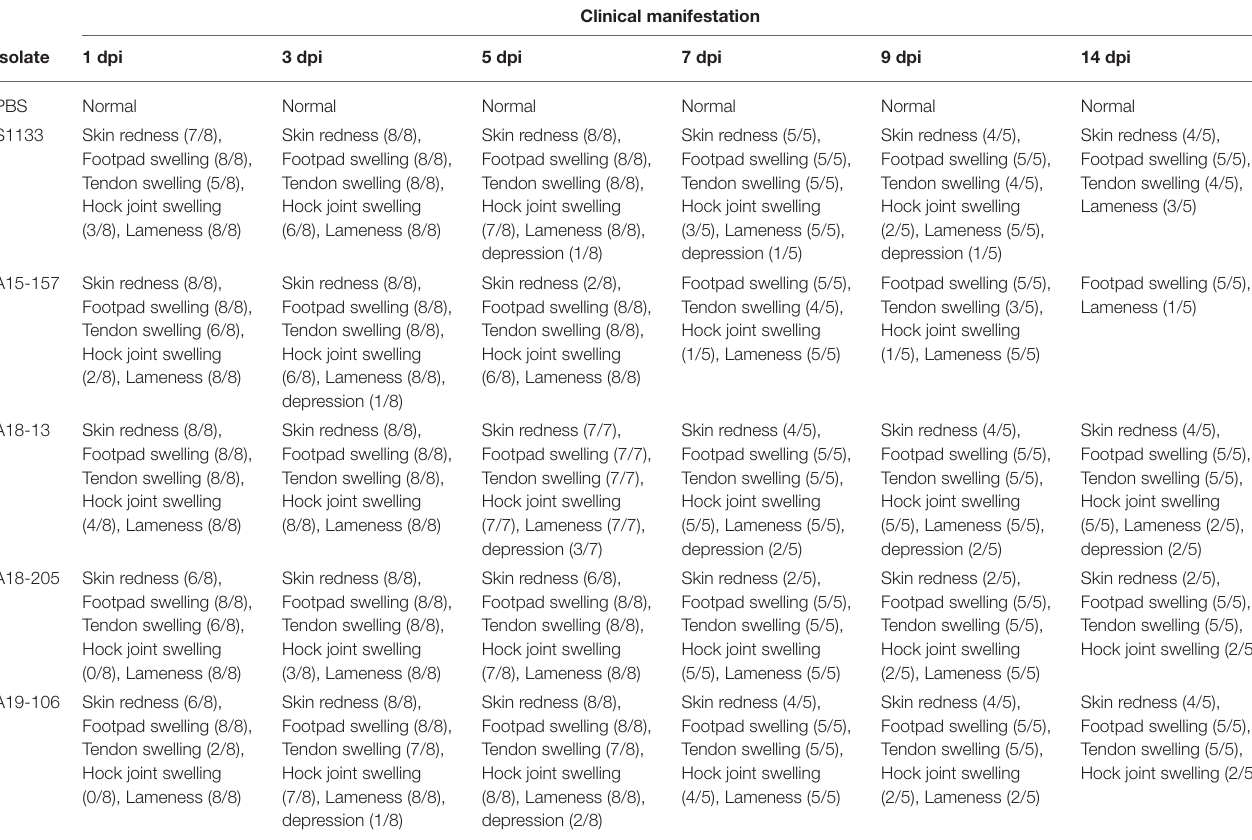
TABLE 2 | The clinical manifestation of chicken infected with ARV originating from wild birds.